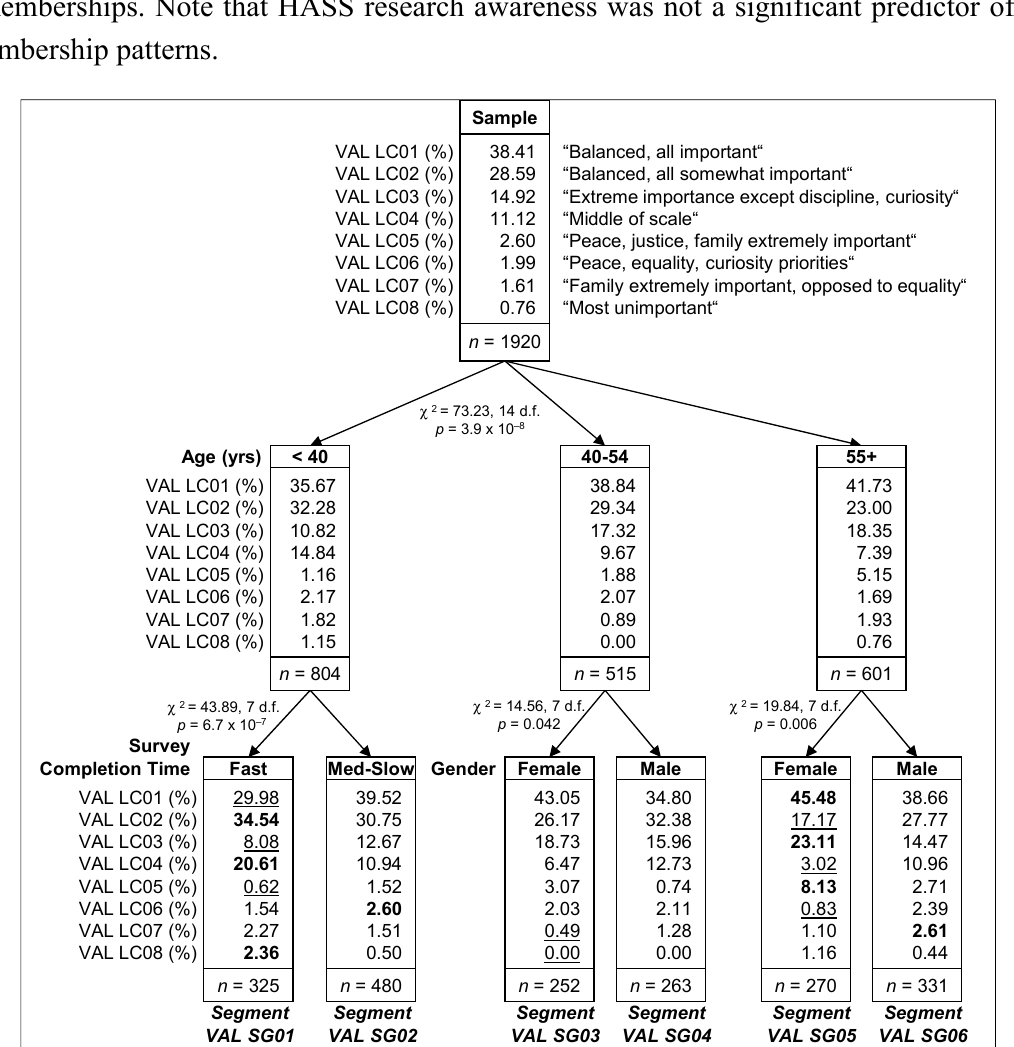
Figure 3. Value-based CHAID segmentation. Bold indicates the highest single value for latent class membership; underlined indicates the single lowest value for latent class